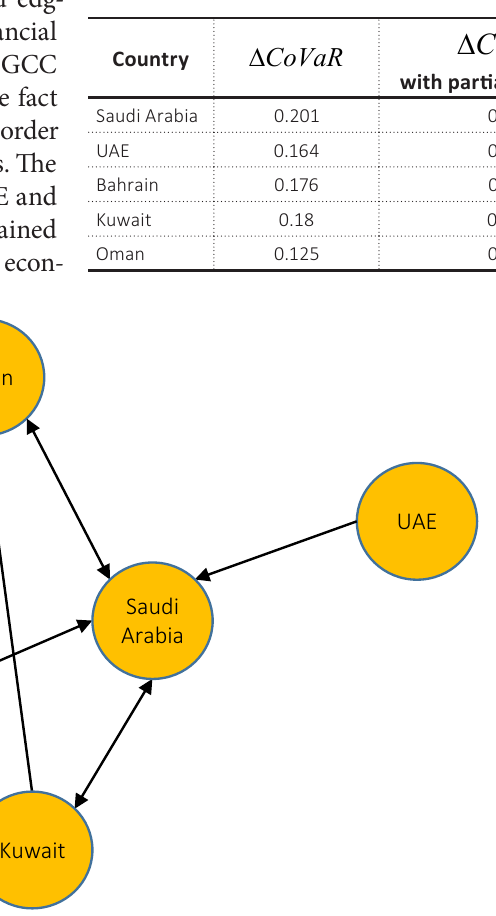
Table 4. Rank concentration ratio of banking